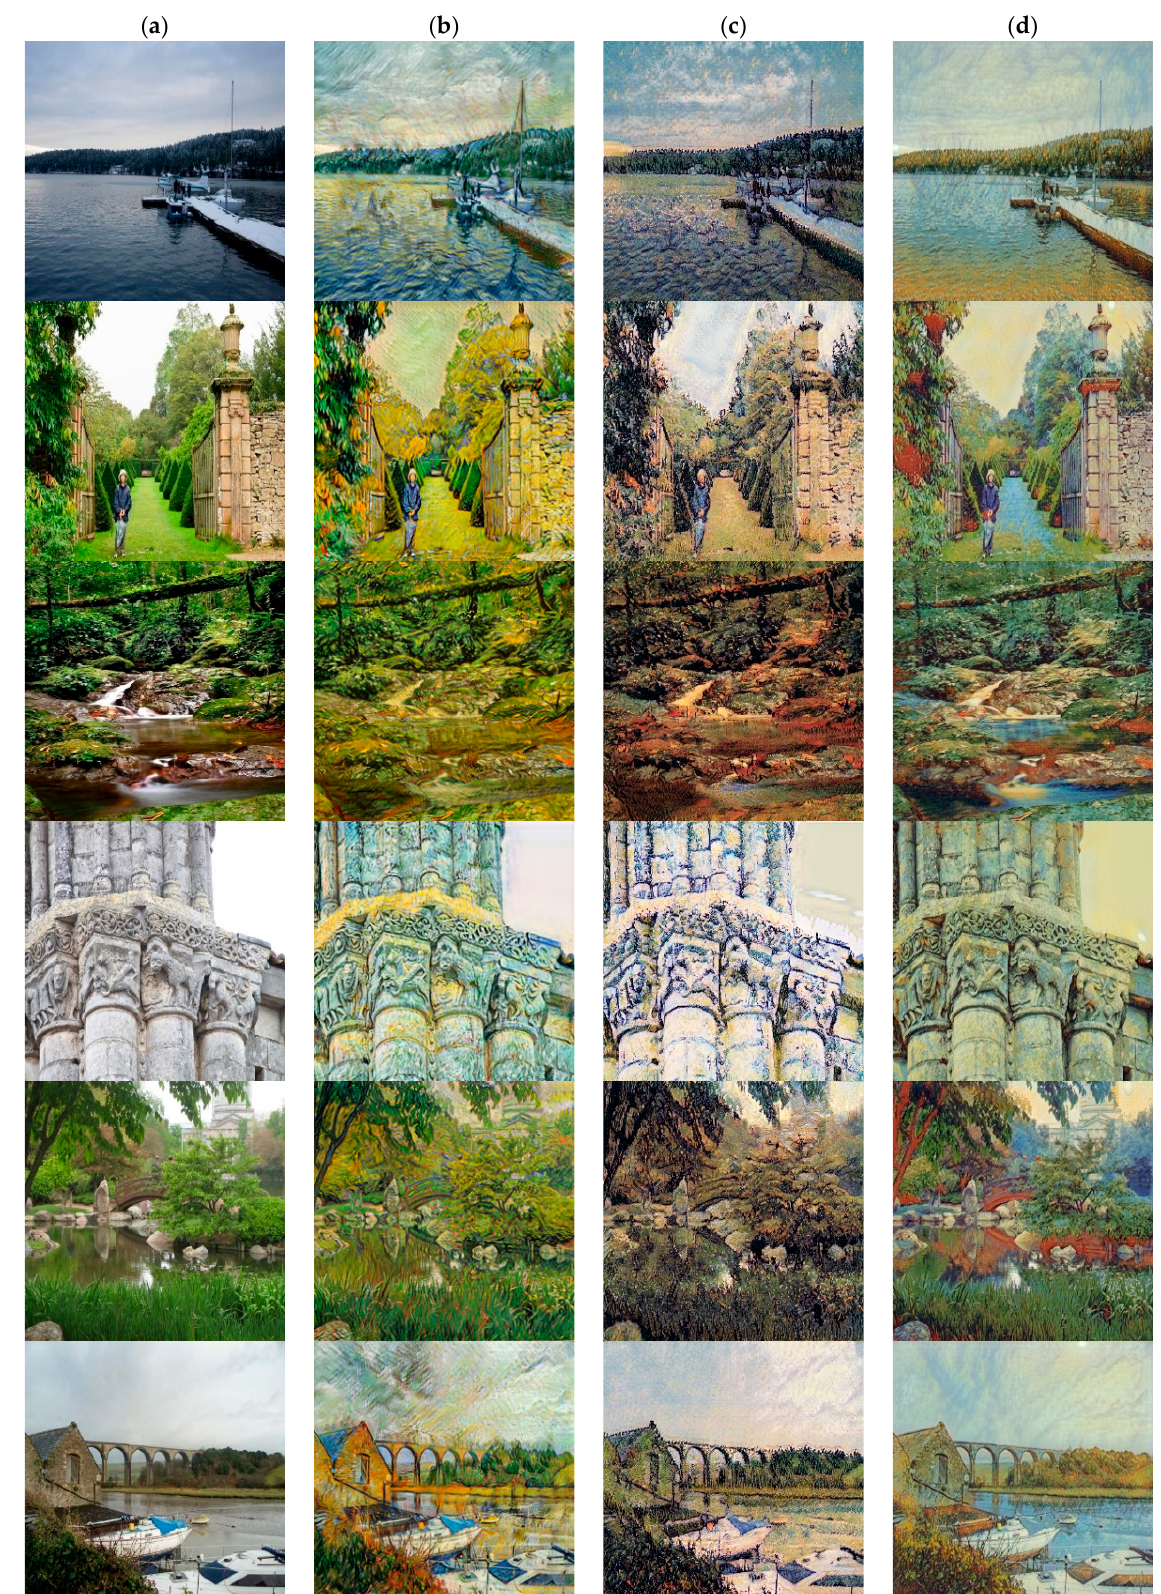
Figure 5. Comparison with different style transfer methods based on the Van Gogh style